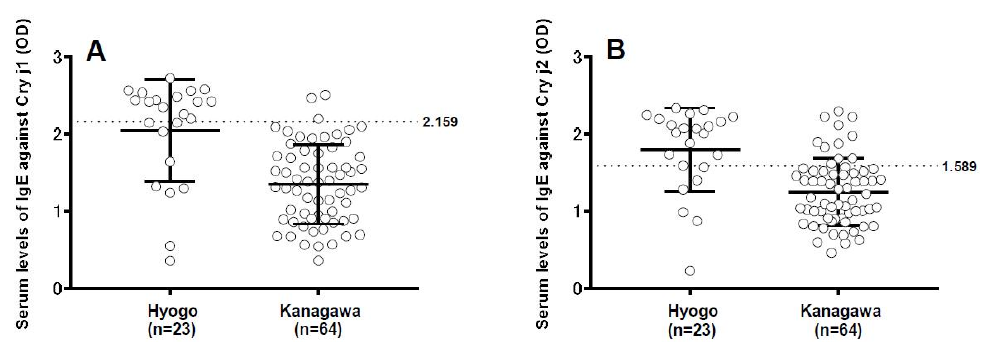
Figure 3. Evaluation of seroprevalence of immunoglobulin E (IgE) antibodies against Japanese cedar pollen allergens Cry j1 and Cry j2 in dogs ( A ) Dot plot showing the distribution of IgE against Cry j1 in dog serum obtained from veterinary hospitals in Hyougo Prefecture (n = 23) and Kanagawa Prefecture (n = 64) by ELISA. ( B ) Dot plot showing the distribution of IgE against Cry j2 in dog serum obtained from veterinary hospitals in Hyougo Prefecture and Kanagawa Prefecture by ELISA. The dotted line indicates the cut-off value, while bars indicate the mean ± standard deviation.